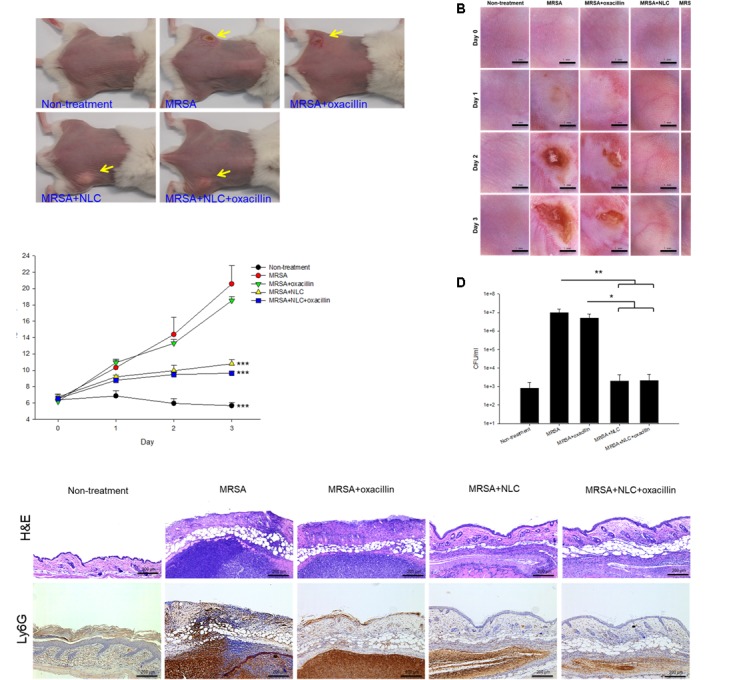
In vivo topical application of oxacillin and/or NLC against MRSA. (A) The representative macroscopic skin surface observation of mouse after a 3-day treatment MRSA injection. (B) The representative skin surface of mouse after treatment of MRSA at day 0, 1, 2, and 3 viewed under handheld digital magnifier. (C) TEWL of mice skin after treatment of MRSA at day 0, 1, 2, and 3. (D) Survival of MRSA in mice skin treated with MRSA. (E) Histological observation of mice skin biopsy stained by H&E and Ly6G antibody after treatment of MRSA. Each value represents the mean ± SD (n = 6). ∗p < 0.05, ∗∗p < 0.01, and ∗∗∗p < 0.001.